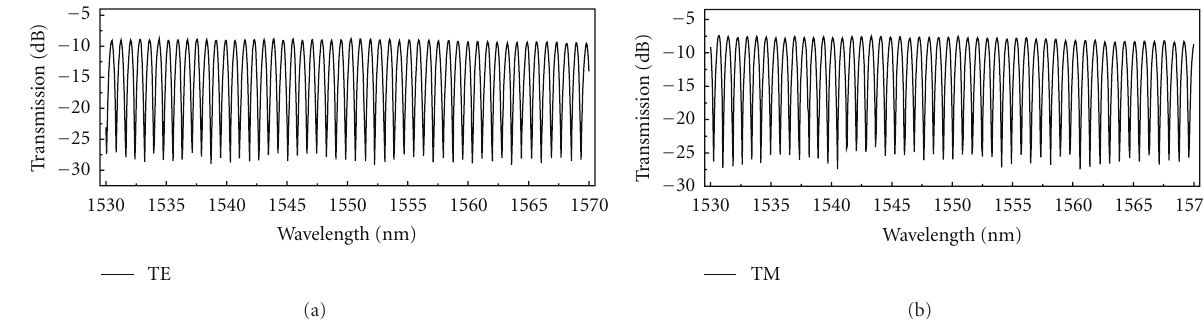
Figure 3: The measured transmission spectra over the entire C band for TE mode (a) and TM mode (b).